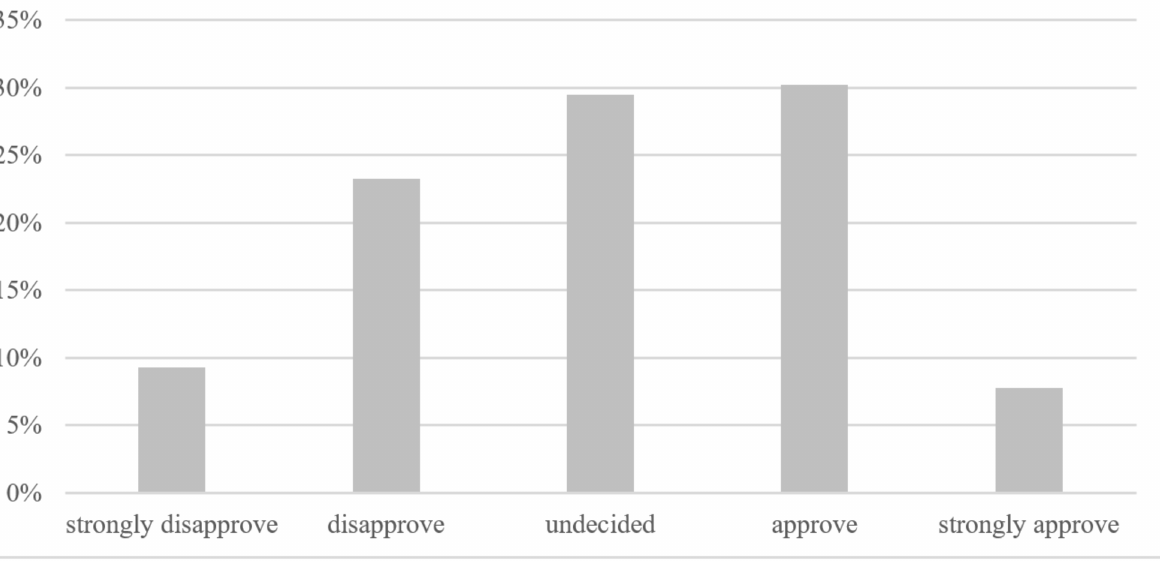
Figure 10. The procedure of loan application assessment in a bank that I represent takes Co2 emission factors into account for investment projects in the energy sector (in percent). Source: own